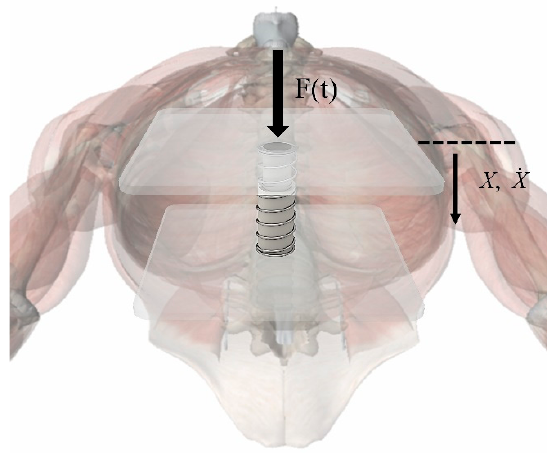
Figure 4. Simplified model of the thoracic cavity.